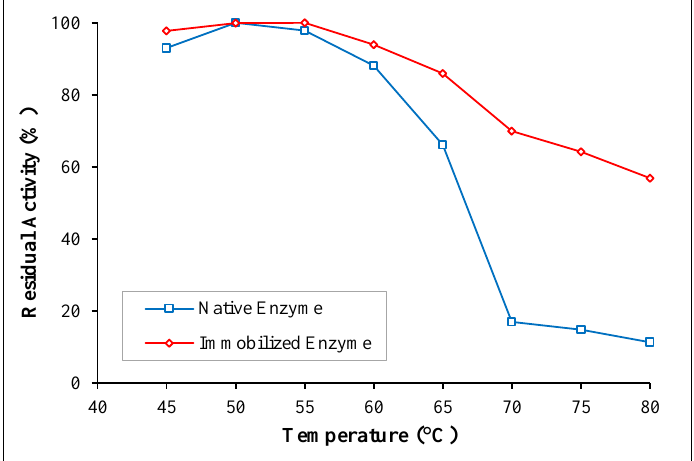
Figure 4. Different temperatures effects on the native and immobilized enzymes activities (mean ± SD; n = 2; p <